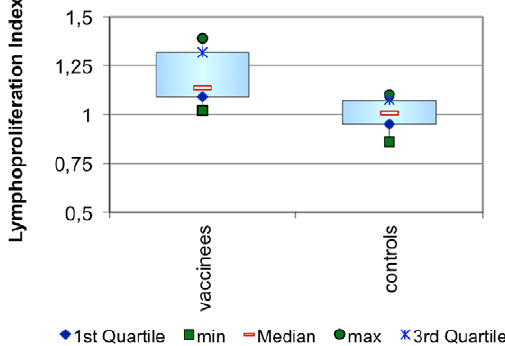
Figure 3. Lymphoproliferation index 3 weeks after the completion of the primary vaccination course. This assay detects the ability of the specific T cells produced as a result of vaccination to proliferate after being exposed to Soluble Leishmania Antigens (SLA). The lymphoproliferation index is the ratio of the mean optical density obtained for the SLA stimulated samples compared to the mean optical density obtained for the non-stimulated samples using a BrdU specific ELISA system.